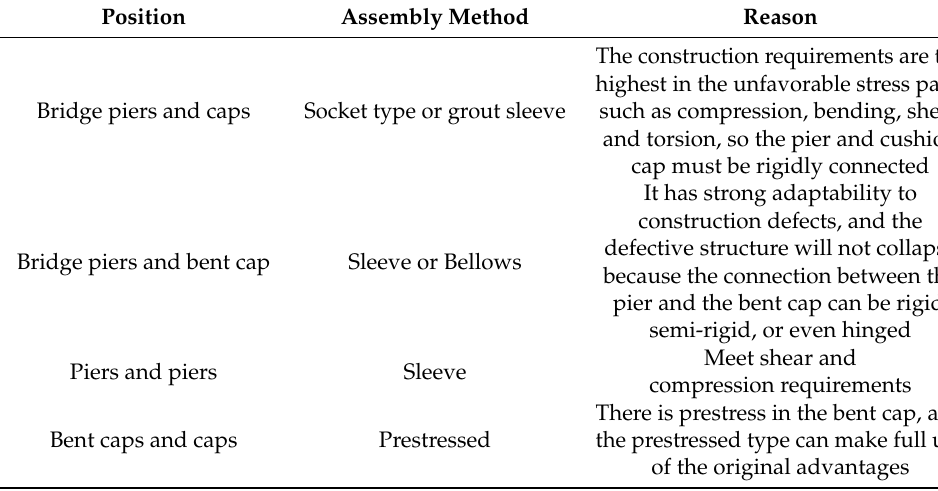
Table 1. Proposed solution of the assembly scheme.